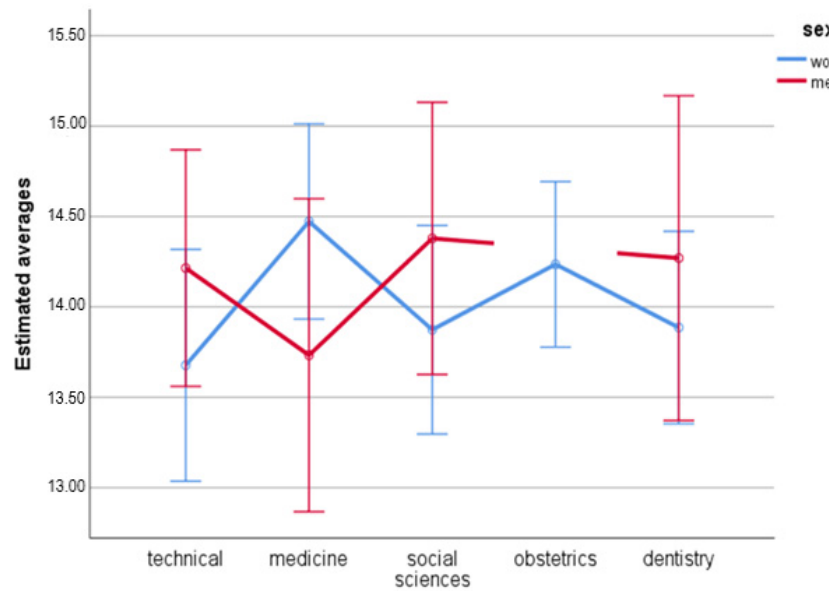
Figure 4. Estimates averages for the fourth domain with regard to sex and field of study.